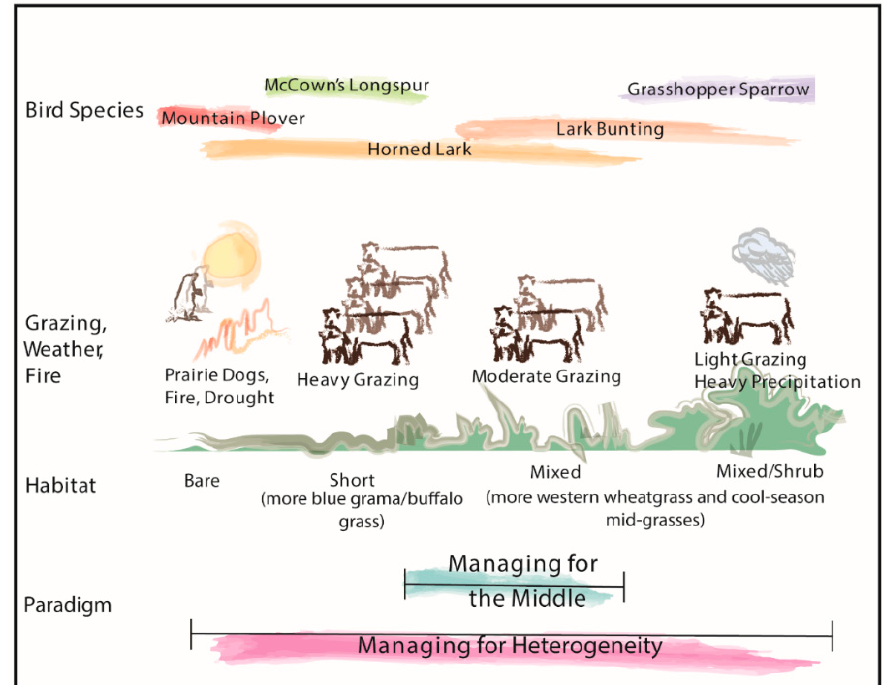
Figure 5. Graphical representation of heterogeneity-based rangeland management paradigm hypothesis. This predicts that a spectrum of vegetation structure from bare ground to tall created through the interaction of ecological disturbances (fire, weather, large herbivore and small-mammal herbivory), provides habitat for a broad suite of grassland species. Heterogeneity-based management contrasts with a “managing for the middle” approach promoted for years in rangeland management to optimize beef production (Bement 1969). Modified from Knopf (1994).